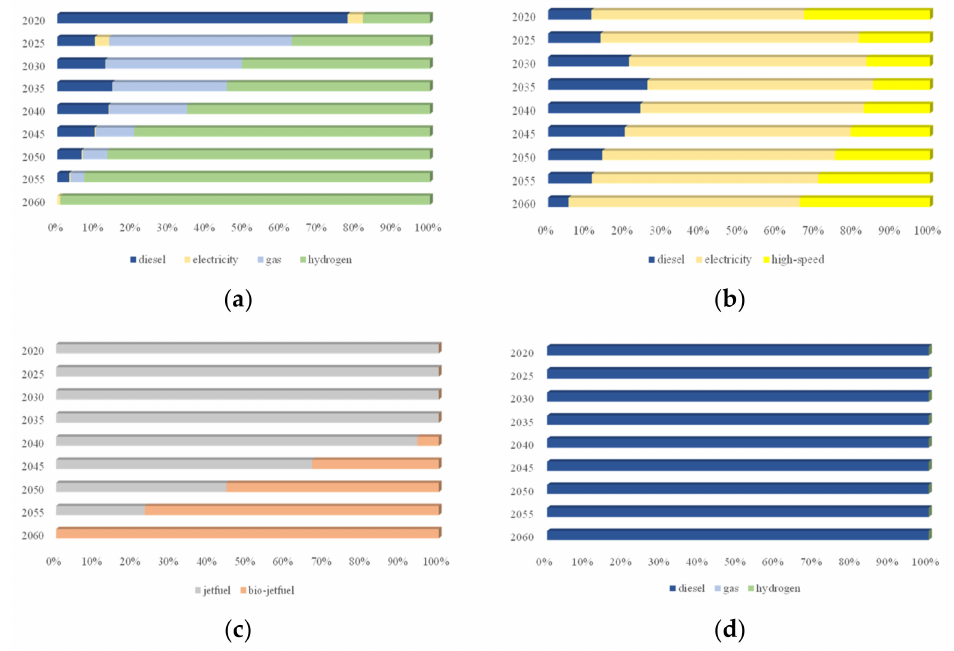
Figure 7. The structure of each inter-city passenger transport mode. ( a ) The structure of coach turnover. ( b ) The structure of train turnover. ( c ) The structure of plane turnover. ( d ) The structure of boat